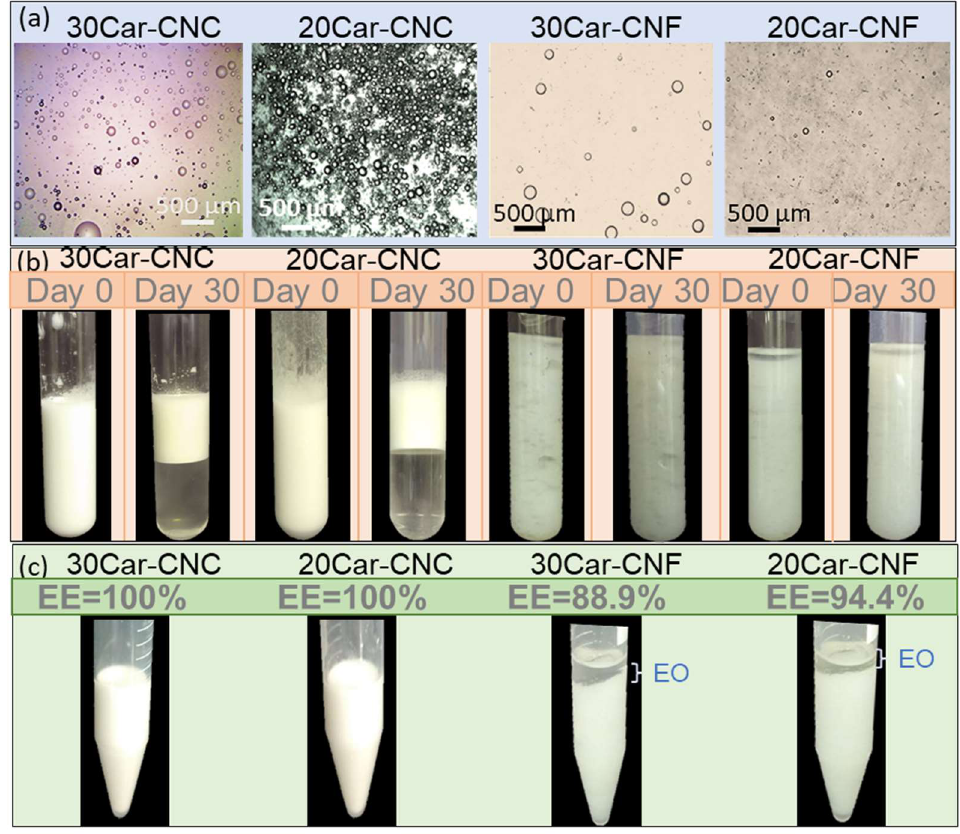
Figure 1. ( a ) Representative optical microscopy images, ( b ) digital photographs obtained from stability on days 0 and 30, and ( c ) stability after centrifugation of the prepared cardamom emulsions stabilized with CNC or CNF.